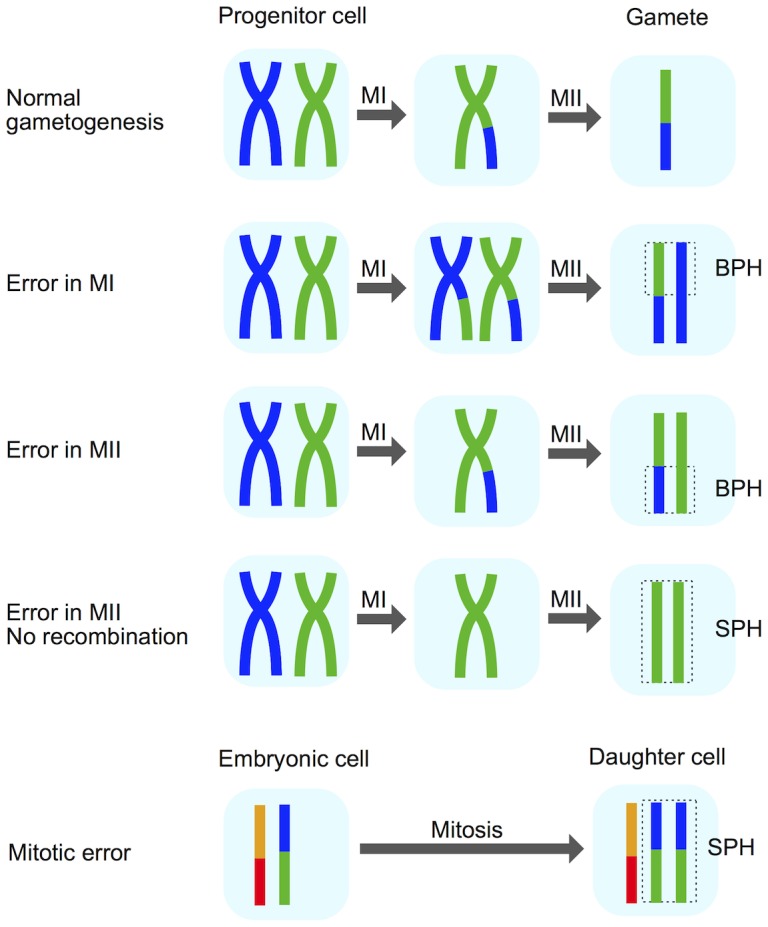
Schematic explaining the BPH signature of meiotic-origin chromosome gain.Certain chromosomal signatures are indicative of meiotic versus mitotic origin of aneuploidy formation. The presence of three unmatched haplotypes (‘both parental homologs’; BPH) in any chromosomal region of the embryo suggests an error in either meiosis I (MI) or meiosis II (MII). Chromosome gains involving identical homologs (‘single parental homolog’; SPH) can arise either by mitotic error or MII errors in the absence of recombination [6, 36]. Reprinted from [36] with permission from Elsevier.